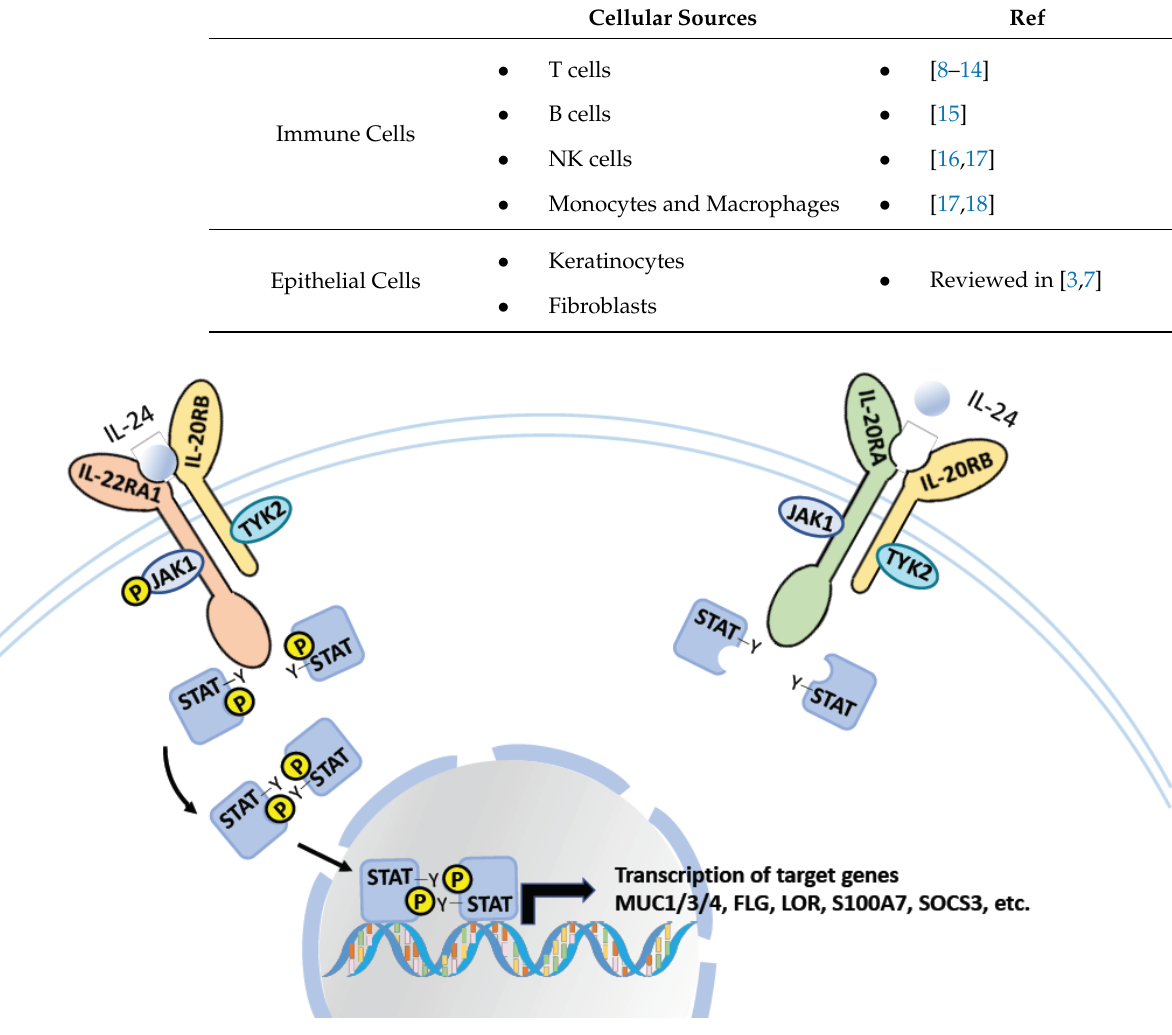
Figure 1. The IL-24 signaling. IL-24 signals through the heterodimeric receptor, IL-20RA/IL-20RB and IL-22RA1/IL-20RB. Both receptors signal through the STAT-JAK signaling pathway for the regulation of gene expression.